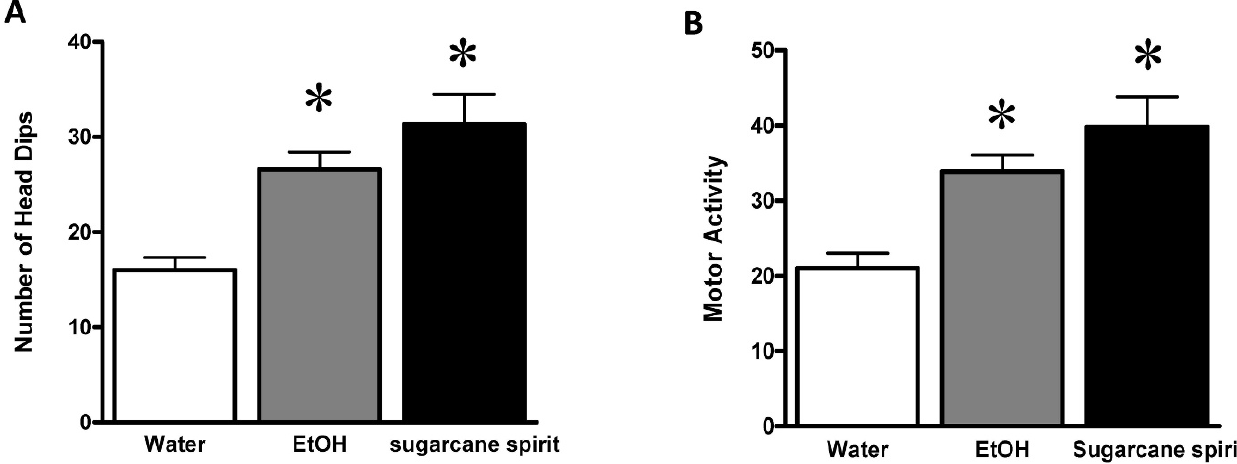
Figure 4 - Hole board test. A . The number of head dips. B . The motor activity, as expressed by the number of quadrants crossed during the time on the board. The data are presented as the mean ¡ SEM. * p , 0.05 compared to the controls